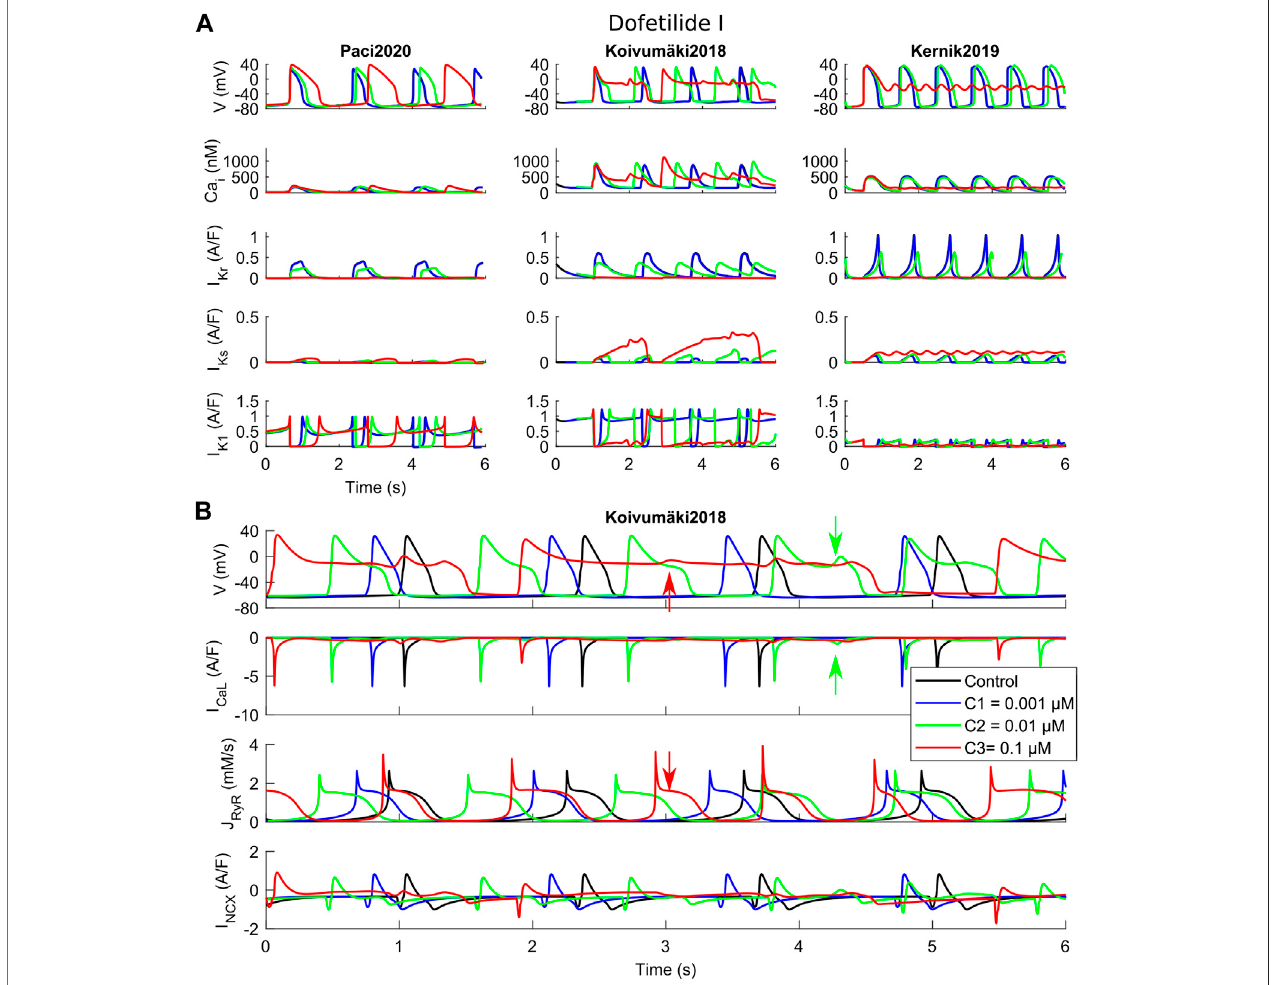
FIGURE 3 | Effects of dofetilide I on the three in silico models for the three tested concentrations (C1, C2 and C3). (A) Comparison of action potentials, Ca 2+ transients and the main K + currents. (B) Detail of the Koivumäki2018 traces, showing the development of EADs following reactivation of I CaL (green arrows) and spontaneous Ca 2+ releases from the sarcoplasmic reticulum (red